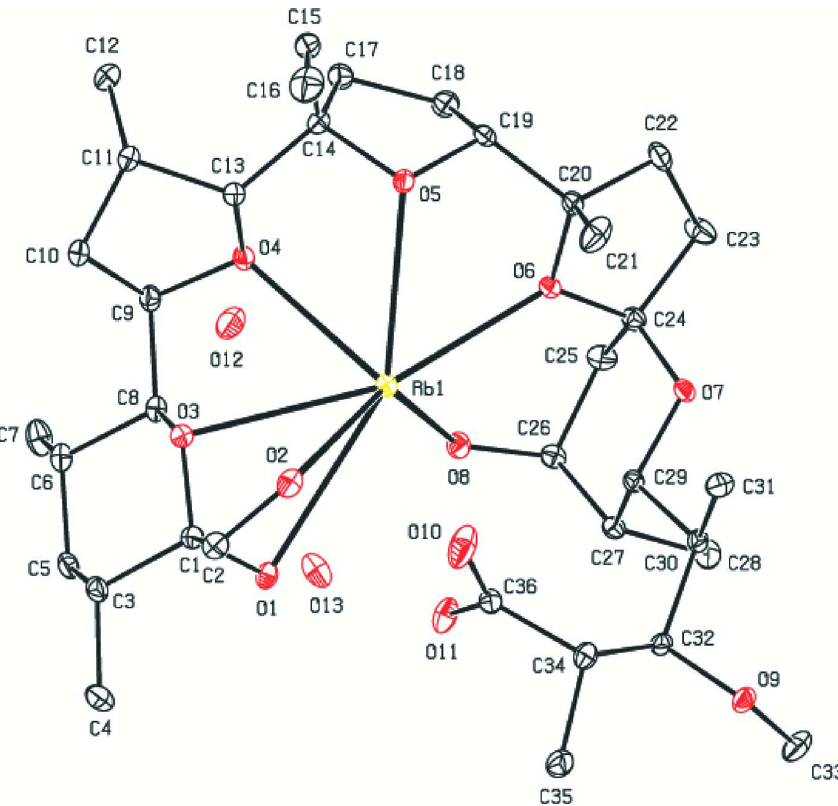
Figure 1 ORTEP view of the title compound with the atom numbering scheme. Displacement ellipsoids for non-H atoms are drawn at the 20% probability level. For clarity, H atoms have been